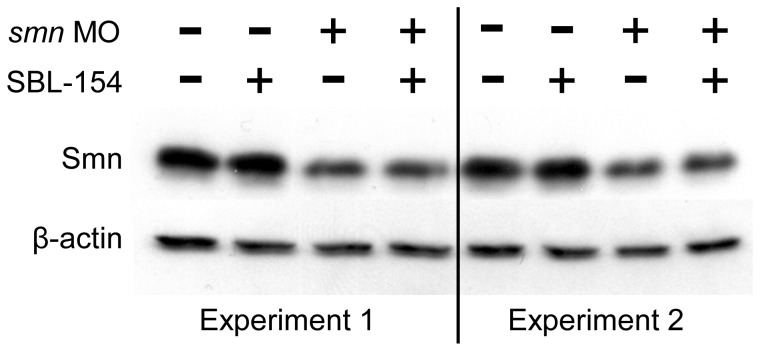
Lack of effect of SBL-154 on Smn protein levels.Zebrafish embryos not injected with morpholino (−) or injected with 9 ng smn MO (+) were treated with either DMSO vehicle (−) or 2 µM SBL-154 (+). Approximately 25 embryos of each of the four classes were pooled, and samples of each class were analyzed by Western blot for Smn protein. β-actin levels were used to normalize protein loading. SBL-154 had no effect on levels of Smn protein in either the presence or absence of smn MO.